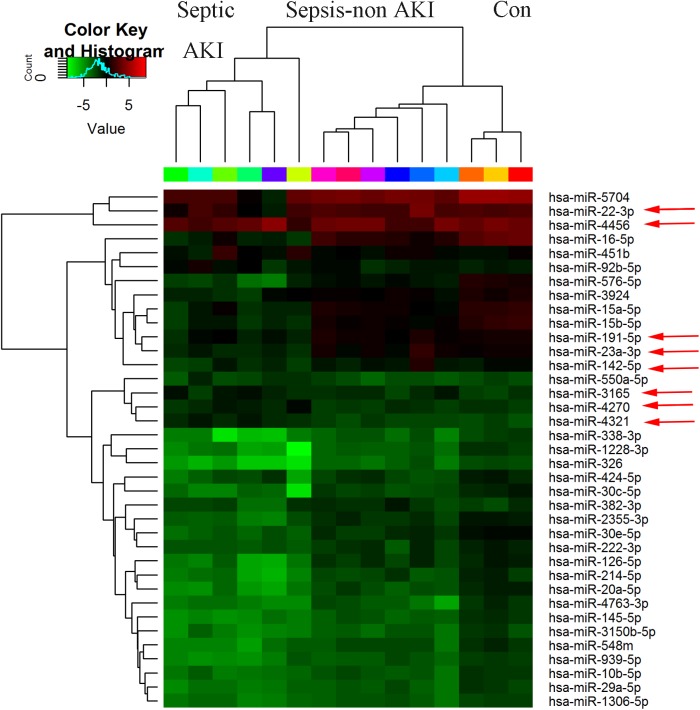
Differentially expressed miRNAs among the three groups.Control (n = 3); Septic AKI (n = 6); Sepsis-non AKI (n = 6). Red color indicated high relative expression and green color denoted low relative expression. miRNA with expression fold change >1.5 and with FDR <0.05 was considered statistically significant. MiRNAs marked with arrow were randomly selected for further confirmation by RT-qPCR.